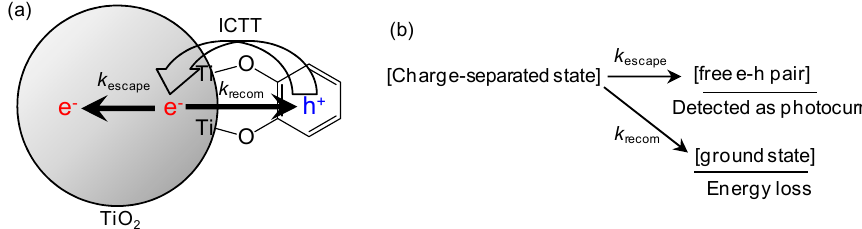
Figure 9. ( a ) Schematic picture of two kinetic processes of electrons injected into TiO 2 by ICTT and ( b ) kinetic scheme of the charge-separated state. Adapted with permission from Reference 2. Copyright 2015 the PCCP Owner Societies.